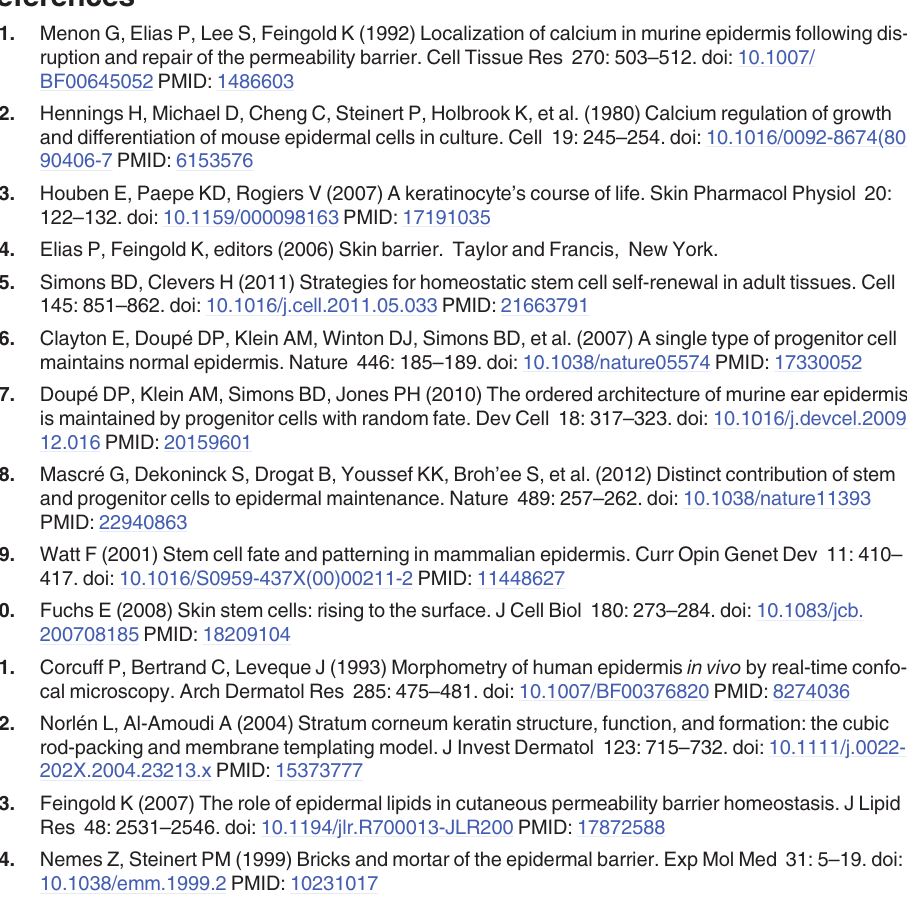
S1 Table. Semi-quantitative extracellular epidermal calcium distributions, determined using ion capture